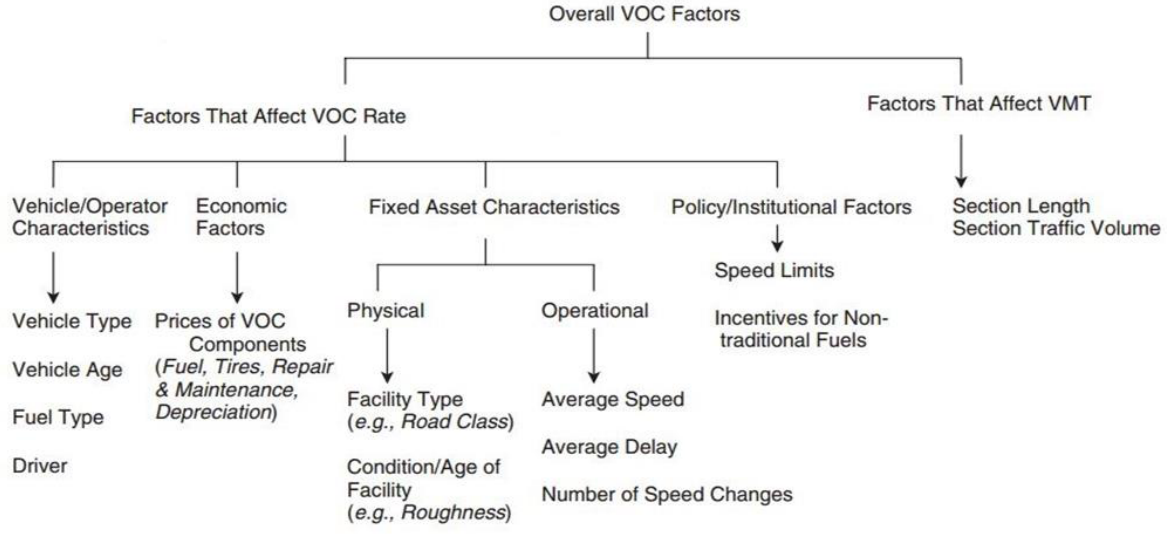
Source : Sinha et al,